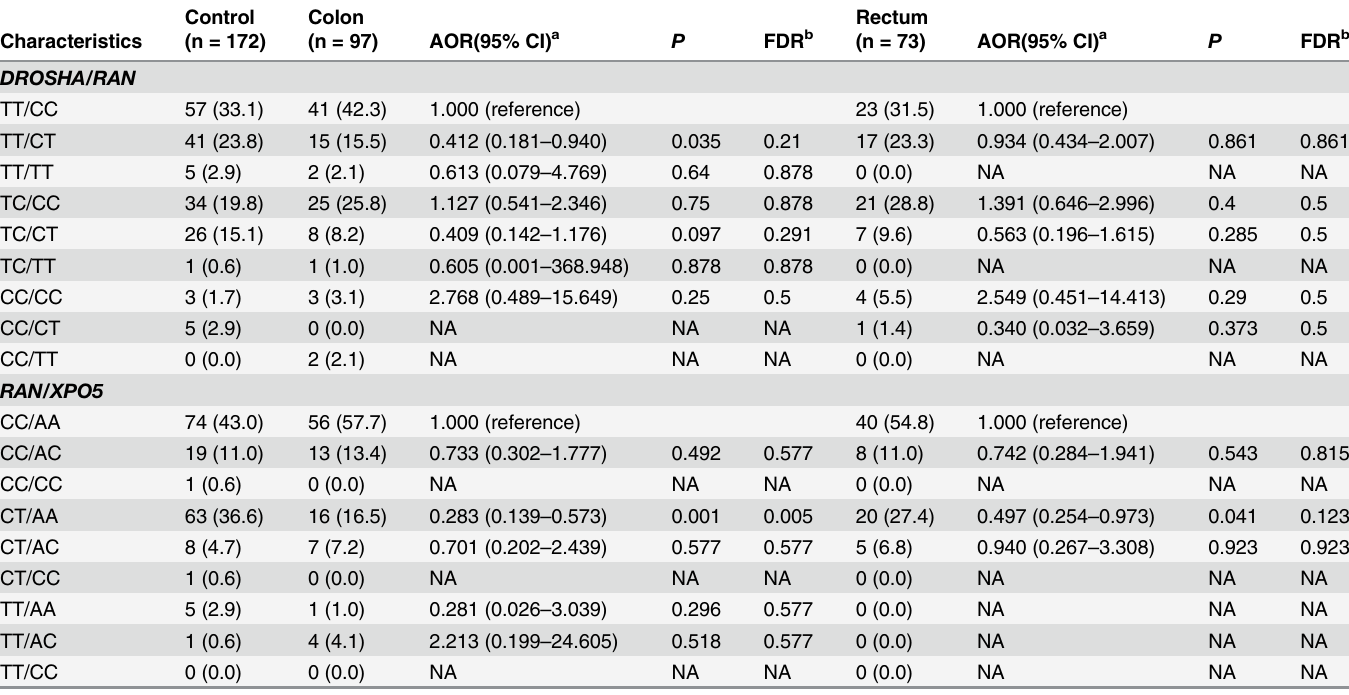
Table 5. The combination of the polymorphisms of microRNA machinery genes in CRC patients and controls: male subgroup.